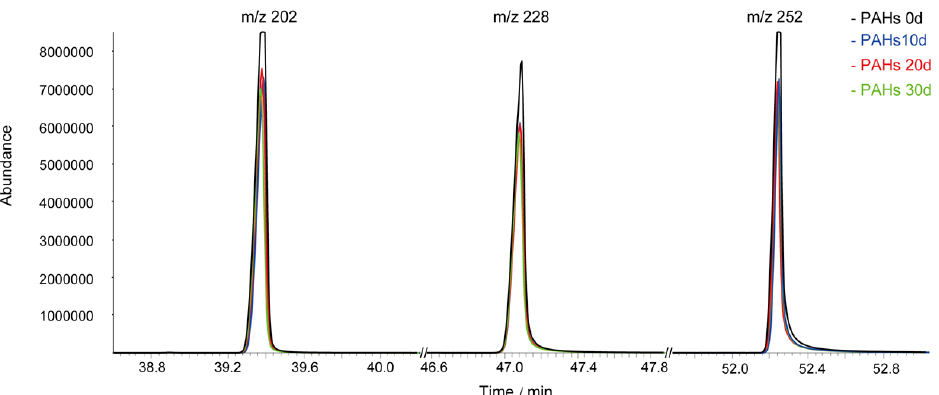
Figure 5. The degradation effect of PAH degrading Bacillus PAH-2 in composite PAHs. The m / z 202, m / z 228 and m / z 252 represented BaA, Pyr, and Bap, respectively.